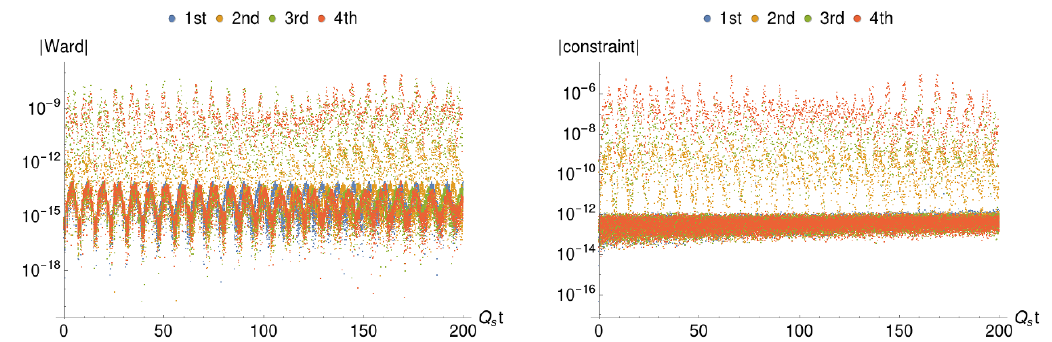
Figure 7 . Left: violation of the holographic Ward identity. Right: constraint in the Einstein